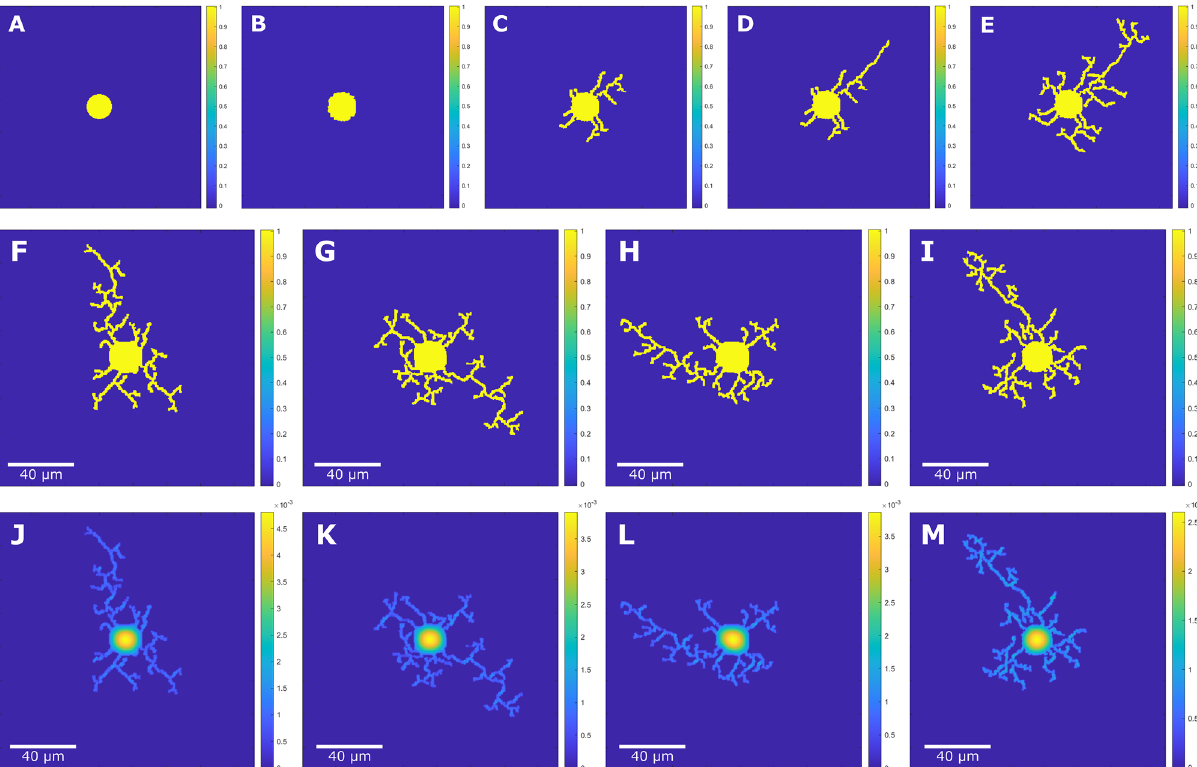
Figure 2. Multi-stage neuron growth phase field result and four single neuron growth results. The phase field variable field φ , is shown in ( A – I ). ( A ) Initial circular cell at the center of the domain of grid size 380 × 380 (0 iteration). ( B ) Stage 1 lamellipodia formation (500 iterations) and ( C ) Stage 2 initial outgrowth of neurites (10,500 iterations) where the neurites grow to similar length with no constraints applied. ( D ) The longest neurite grows out further than the rest of the neurites using an extracellular cue-based energy activation zone approach, leading to stage 3 axon differentiation (28,500 iterations). ( E ) Stage 4 dendrite formation (35,000 iterations) is observed by allowing the neurite extension and branching for more iterations. ( F – I ) shows four phase field model results of single neuron growth using different θ initializations using grid size of 383 × 383 , 303 × 303 , 363 × 363 , and 343 × 343 respectively. Each case exhibits growth behavior from stage 1 lamellipodia formation to stage 4 dendrite formation with observable stage 3 axon differentiation. The axon growth exhibits similar angle changes with experimental data-based extracellular cue placement. ( J – M ) Intracellular tubulin concentration field is shown for the corresponding phase field